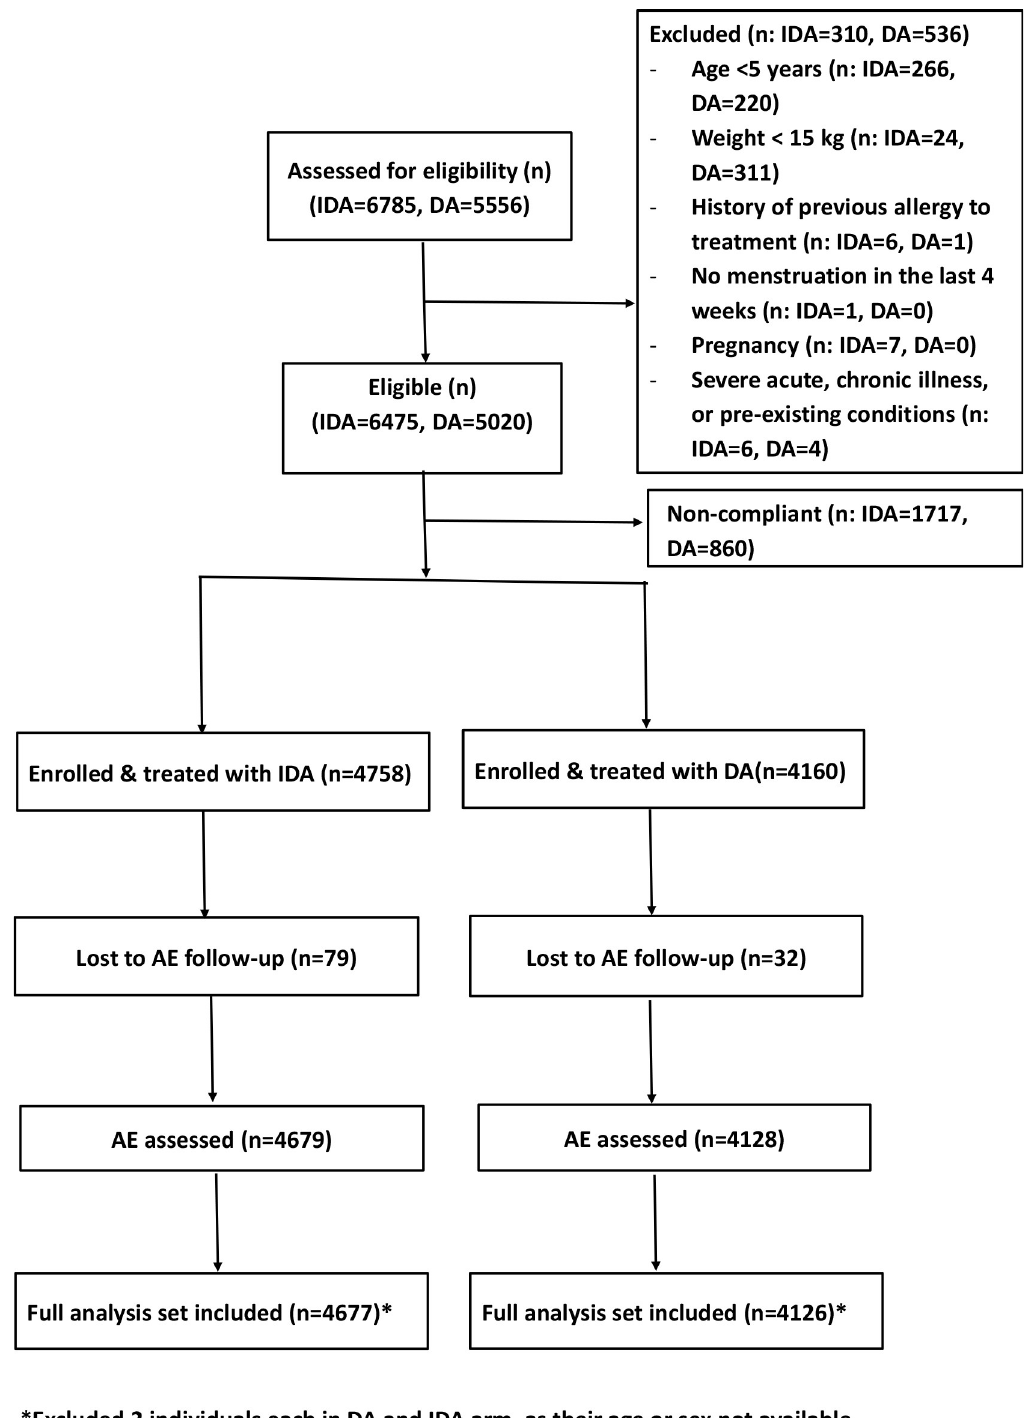
Fig 2. CONSORT diagram. Treatment allocation was by block randomization (DA: Diethyl carbamazine plus albendazole and IDA: ivermectin+DA).